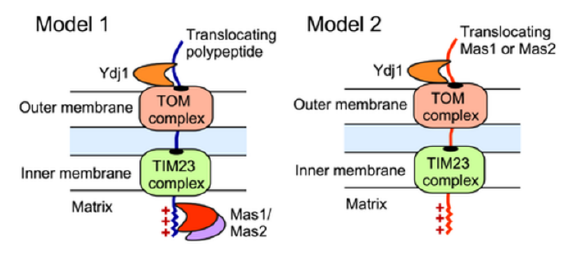
FIGURE 9: Schematic illustrating two possible models of Ydj1 interaction with the MPPs. Such interactions might be indirect via binding of Ydj1 to the protein substrates processed by MPP (model 1), or direct upon the translocation of either Mas1 or Mas2 to the mitochondria (model